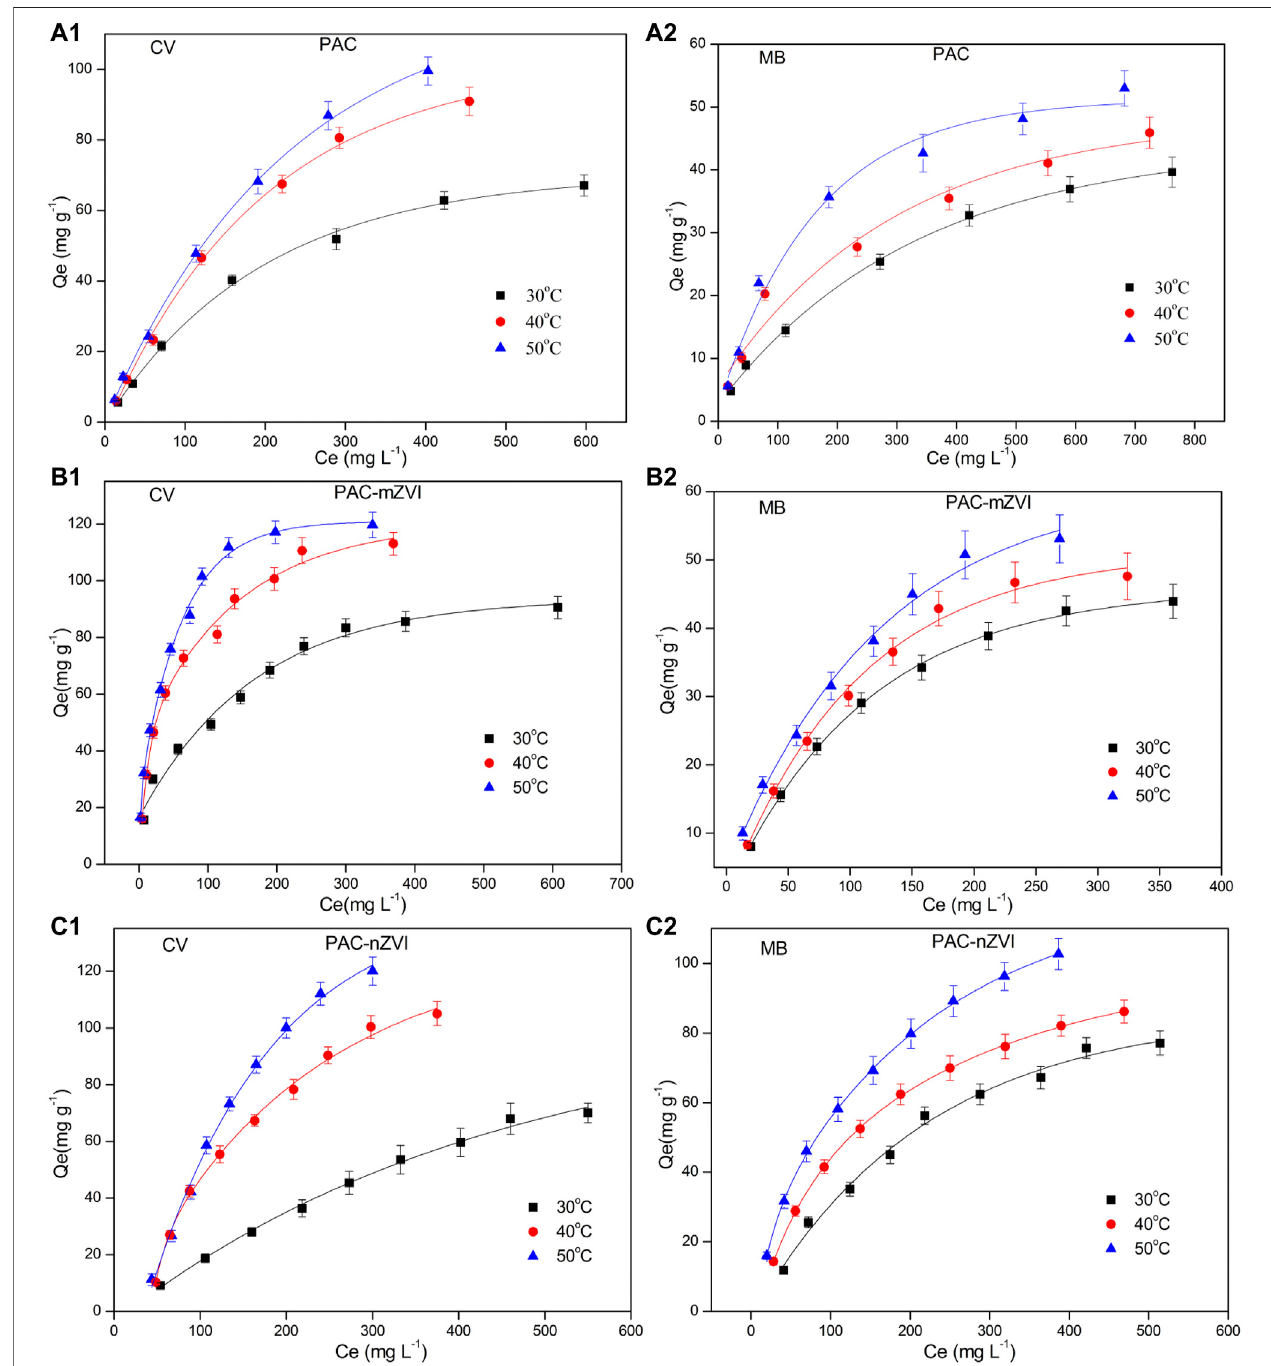
FIGURE 8 | Adsorption isotherms of CV and MB adsorbed onto PAC and PAC-based ZVI adsorbents, (A 1 ) CV by PAC; (A 2 ) MB by PAC; (B 1 ) CV by PAC-mZVI; (B 2 ) MB by PAC-mZVI; (C 1 ) CV by PAC-nZVI; (C 2 ) MB by PAC-nZVI.